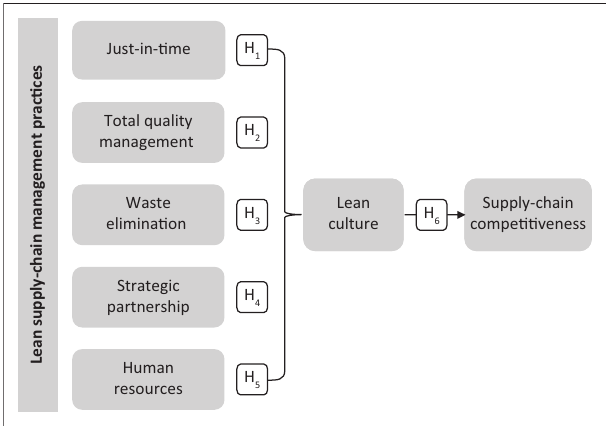
FIGURE 1: Conceptual